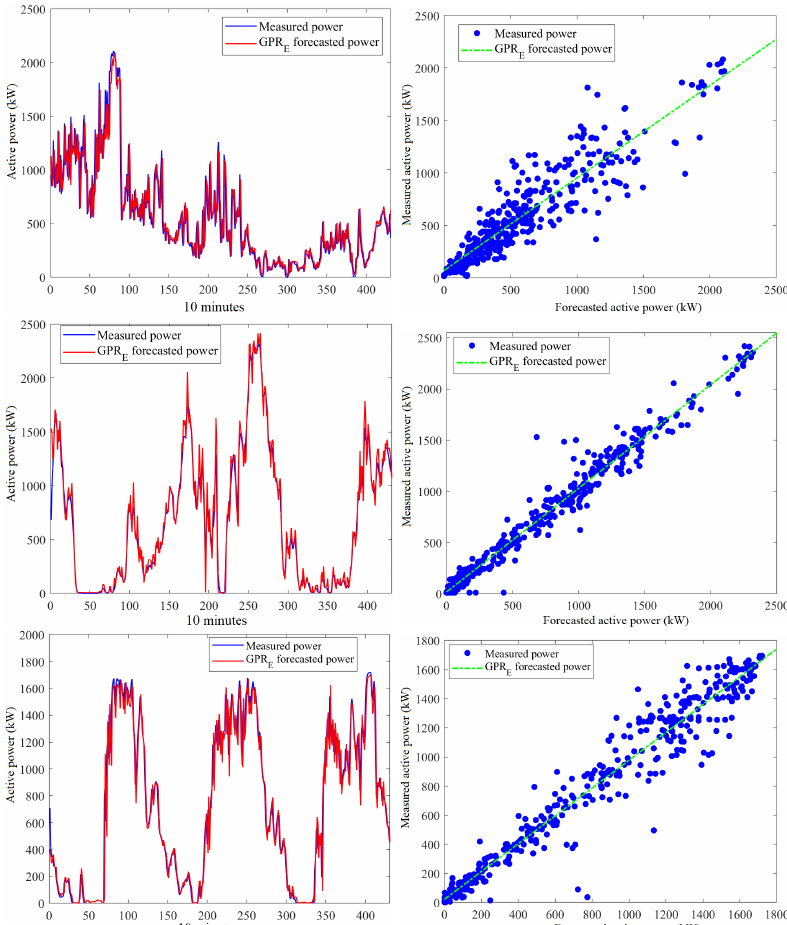
Figure 10. Forecasted wind power from the GPR model based on test data from: ( Top ) France, ( Middle ) Turkey, and ( Bottom )